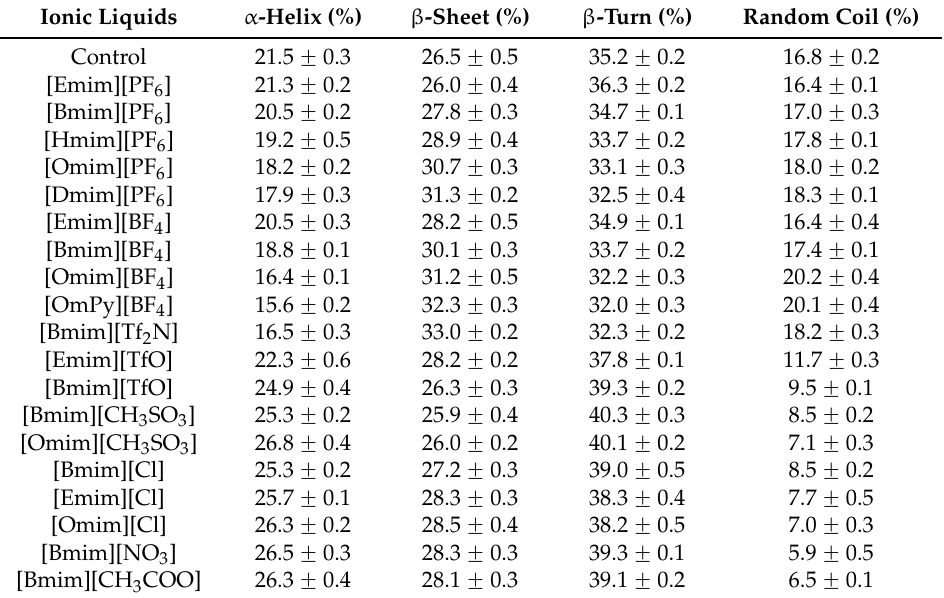
Table 2. The secondary structure elements of EST in ILs by CD spectroscopy.